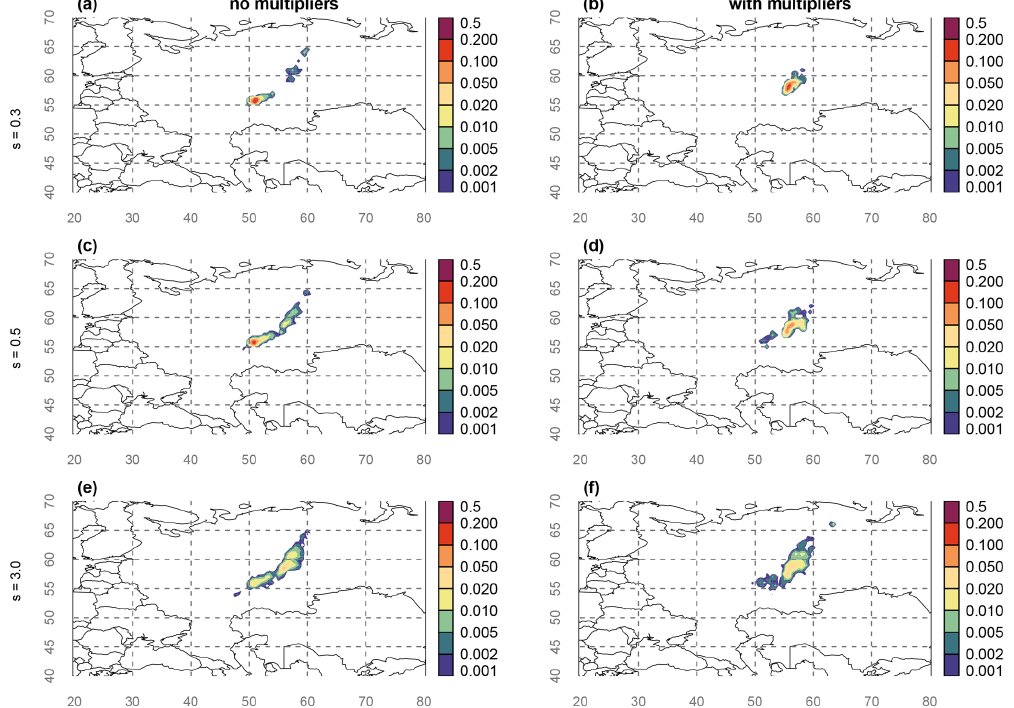
Figure 3. Source location probability maps obtained from the Bayesian source reconstruction. The model uncertainty parameters of the inverse gamma distribution were fixed a priori, and different values for s were used in the panels: s = 0 . 3 in (a) , (b) , s = 0 . 5 in (c) , (d) and s = 3 . 0 in (e) and (f) . No multipliers were used in (a) , (c) and (e) , while multipliers were used in panels (b) , (d) and (f) (see Sect. 4.3 for details). The longitude and latitude are shown by grey numbers and dashed